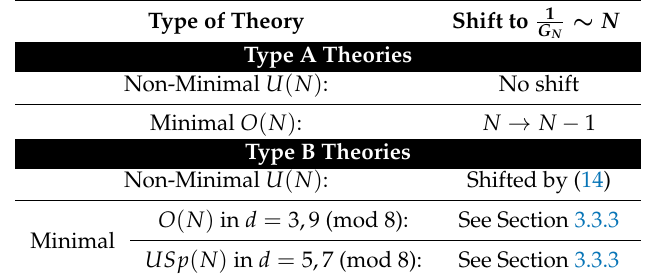
Table 2. Summary of results of one-loop calculations for odd d > 0. Again, by no shift, we mean that there are no shifts to the coupling constant coming from the spectrum of the particular theory. Results for Type A theories taken from